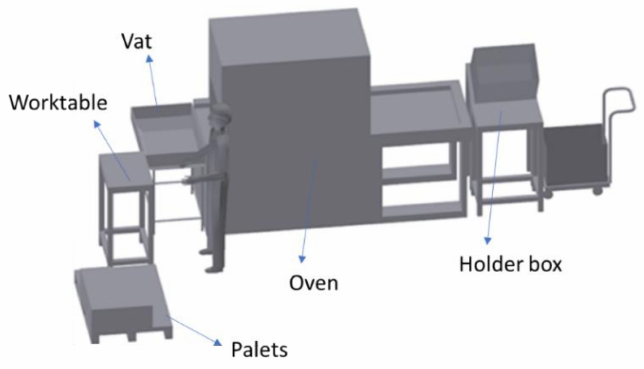
Figure 25. Standardized packaging